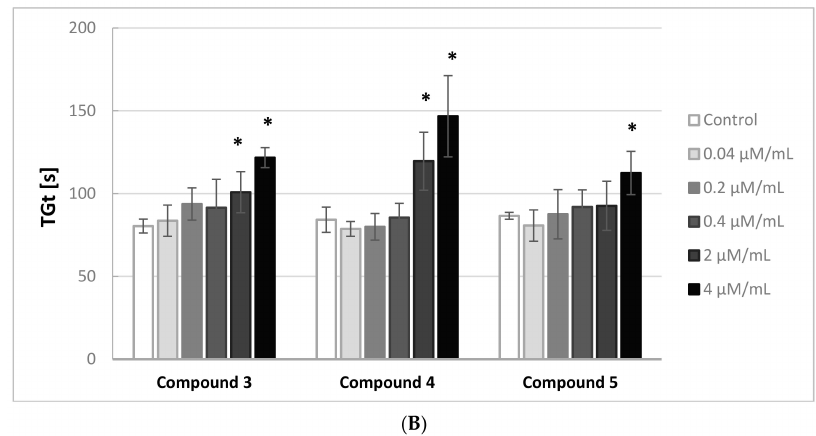
Figure 2. Results of coagulation assay. Influence of iminodiacetic acid derivatives ( A ) compounds 1 and 2 ; ( B ) compounds 3 – 5 on thrombin generation time (TGt) (mean ± SD, n = 5) after 3 min incubation in plasma; final volume 500 µ L. All compounds at the highest tested concentration 4 µ mol/mL statistically significantly prolonged TGt. * p <